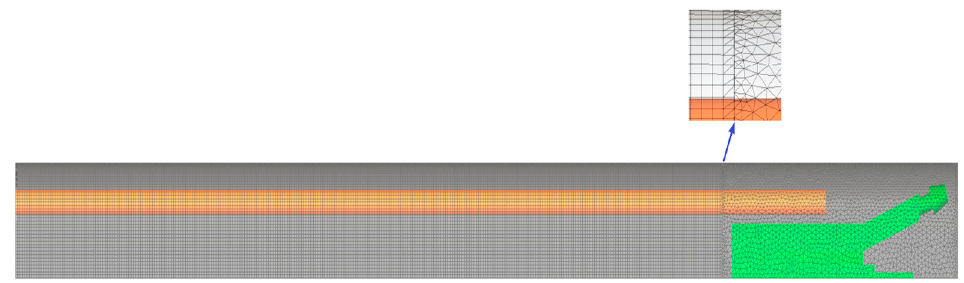
Figure 4. Laneway model using medium mesh.